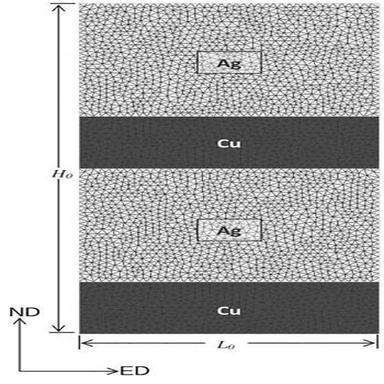
Schematic of the hetero-phase bicrystal model consisting of triangular elements. To simulate plane strain compression, a prescribed displacement corresponding to the thickness reduction is applied to the top edge. The left and bottom edges are constrained from moving in the Elongation Direction (ED) and Normal Direction (ND) directions, respectively. The right edge is free to move in the Elongation Direction (ED) direction. Figure adopted from with permission from Elsevier.